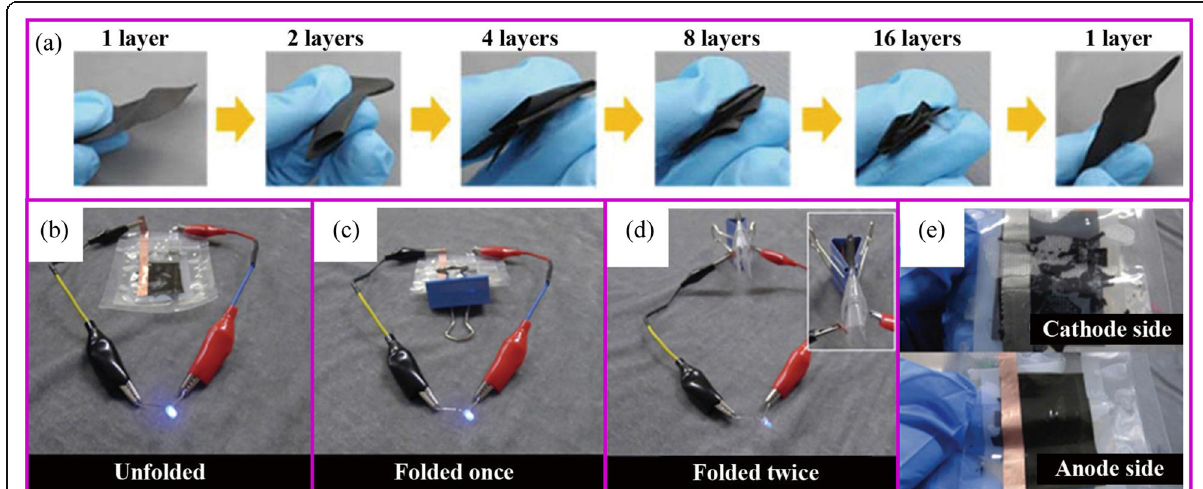
Fig. 12 a Digital photographs of Zn(CH 3 COO) 2 -PAN film, which can be folded four times. LED lighting tests of a full battery when b flat, c folded once, and d folded twice; and e digital photographs of the electrode after the LED lighting test